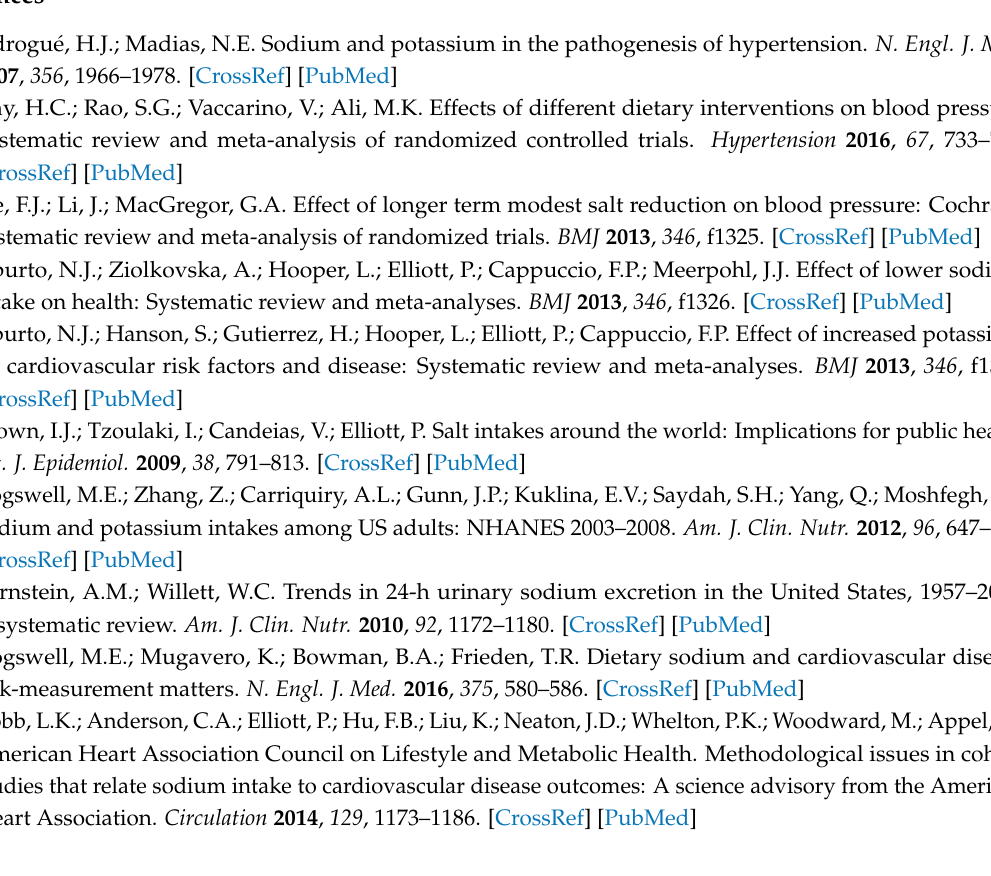
Figure S1: (a) Urinary Na/K ratio monitor (HEU-001F, Omron Healthcare Co., Ltd., Kyoto, Japan); (b) Pearson’s correlation coefficient for the urinary Na/K ratios measured by the portable urinary Na/K ratio monitor (HEU-001F, Omron Healthcare Co., Ltd., Kyoto, Japan) and by a biochemical inspection center (BML Inc., Tokyo, Japan). Figure S2: Correlation between one random spot urine Na/K ratio as well as the average of three, five, or seven random spot urine Na/K ratios obtained during the last three days of each diet period and the 24-h urine Na/K ratio obtained on the last day of each diet